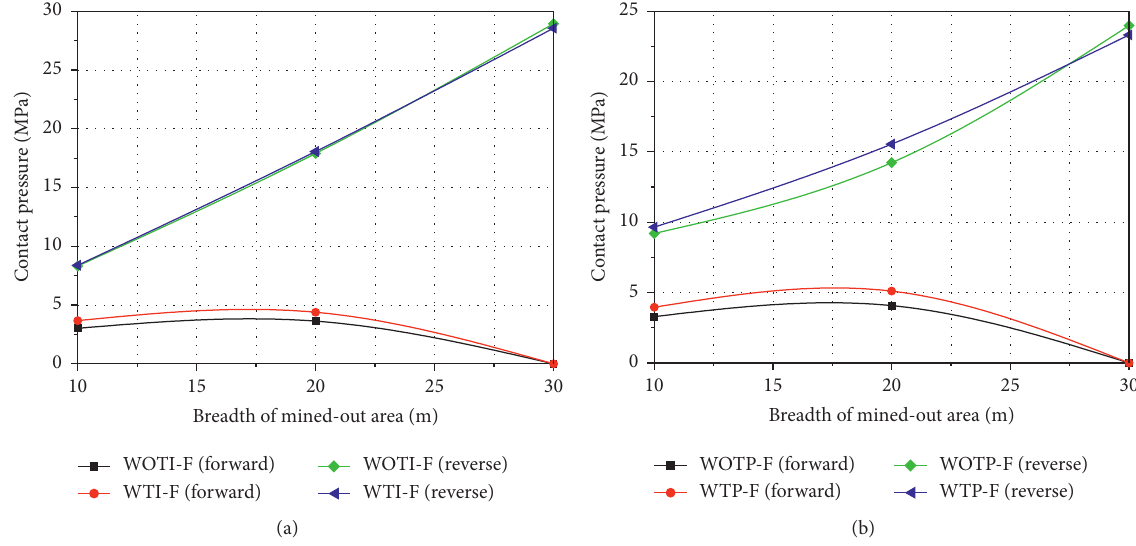
Figure 27: The change of contact pressure of underside fault along with the breadth of mined-out area. (a) Initial fracture. (b) Periodical